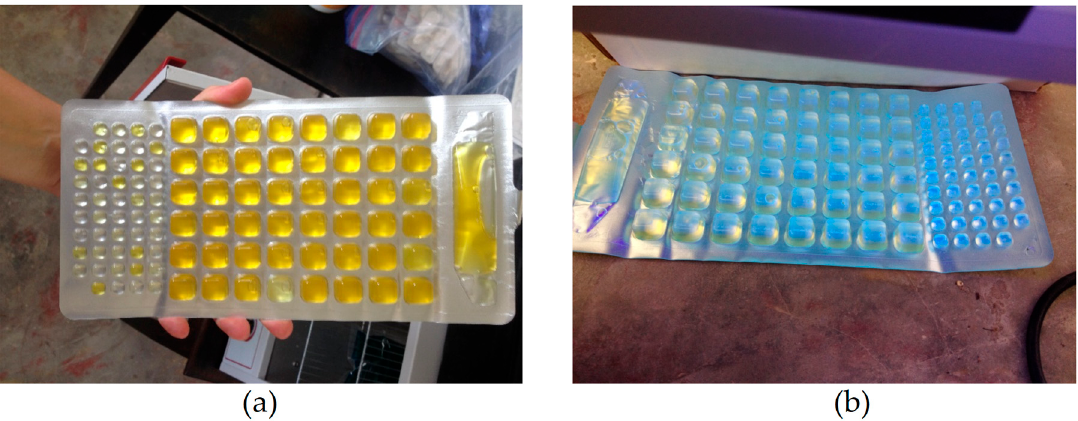
Figure 5. IDEXX Colilert–18 Quanti–Trays: ( a ) water sample testing positive for coliform; ( b ) water sample under UV light, testing positive for E. coli .